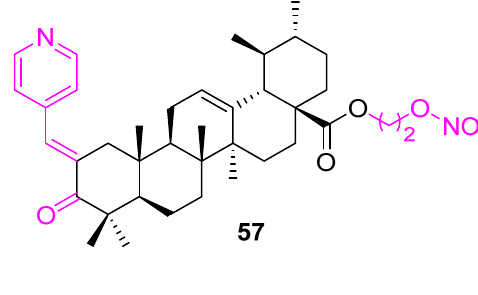
Figure 39. Structure of 56 , 57 .